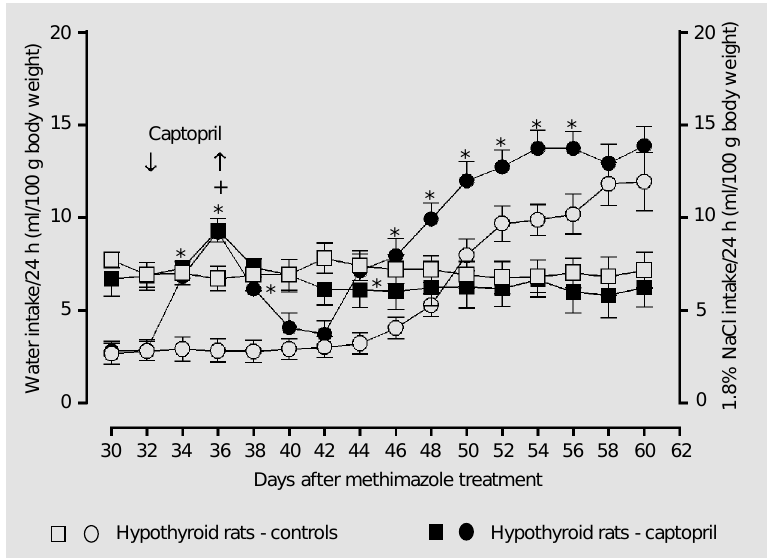
Figure 1 - Mean 24-h water (squares) and sodium (circles) intake of hypothyroid rats treated with captopril (1 mg/g added to the food, from day 32 to day 36). Arrows represent days on which captopril was added and removed from the food. * + P<0.05 for 1.8% NaCl and water intake, respectively, compared to hypothyroid control rats (ANOVA and Student-Newman-